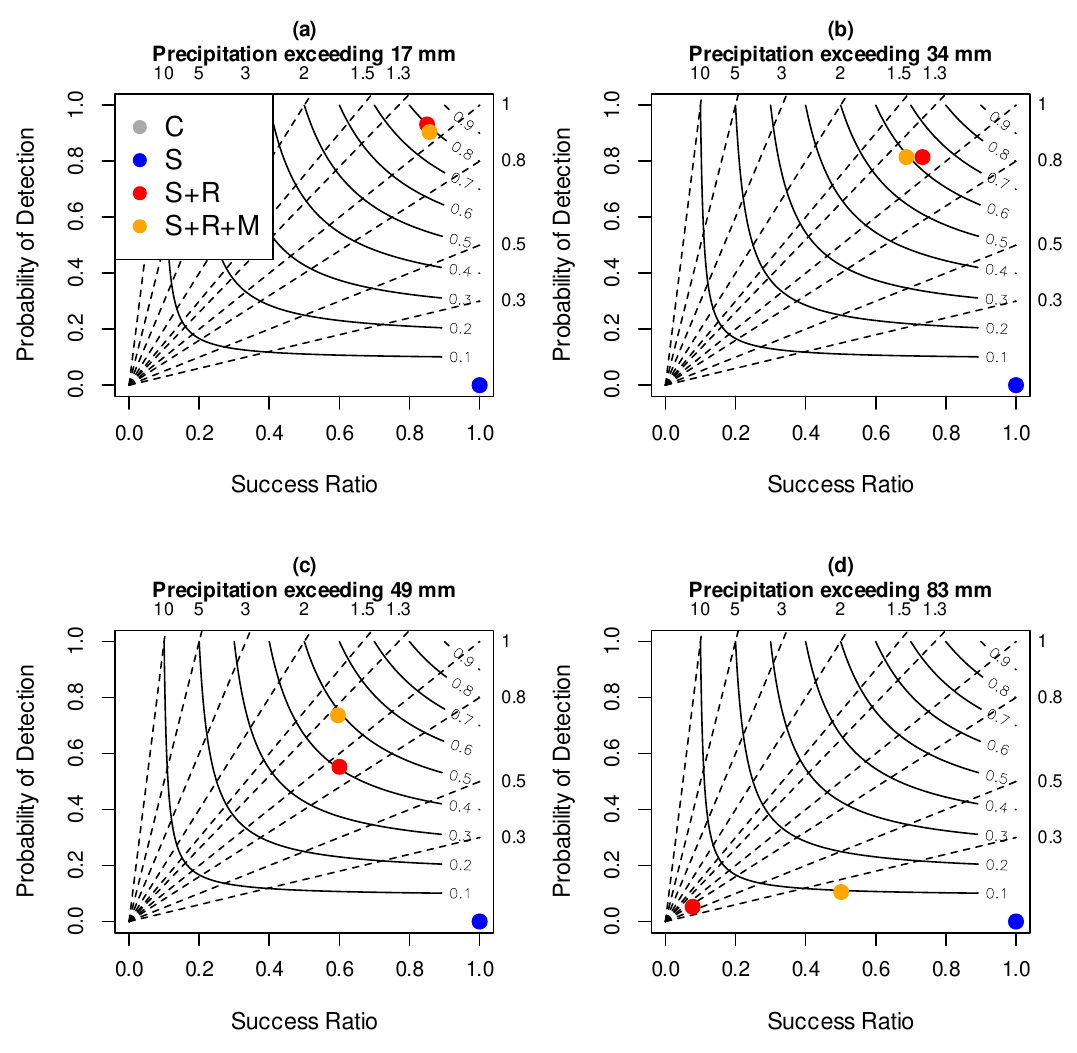
Figure 9. Performance diagrams for selected precipitation thresholds accumulated in the 6 h period ending at 0300 UTC, 10 September. In each panel the x -axis shows the success ratio ( SR ), the y -axis shows the probability of detection ( POD ), the curved lines represent critical success index ( CSI ) values, and the dashed diagonal lines represent bias . In each panel, the blue point overlaps the gray